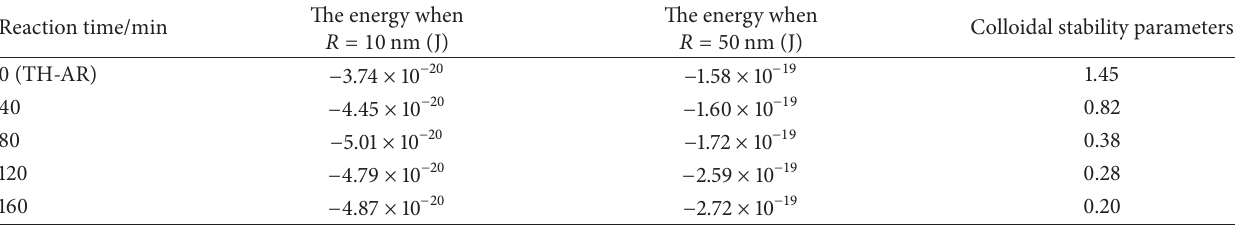
Table 5: The attractive energy between colloids of TH-AR for model #7.